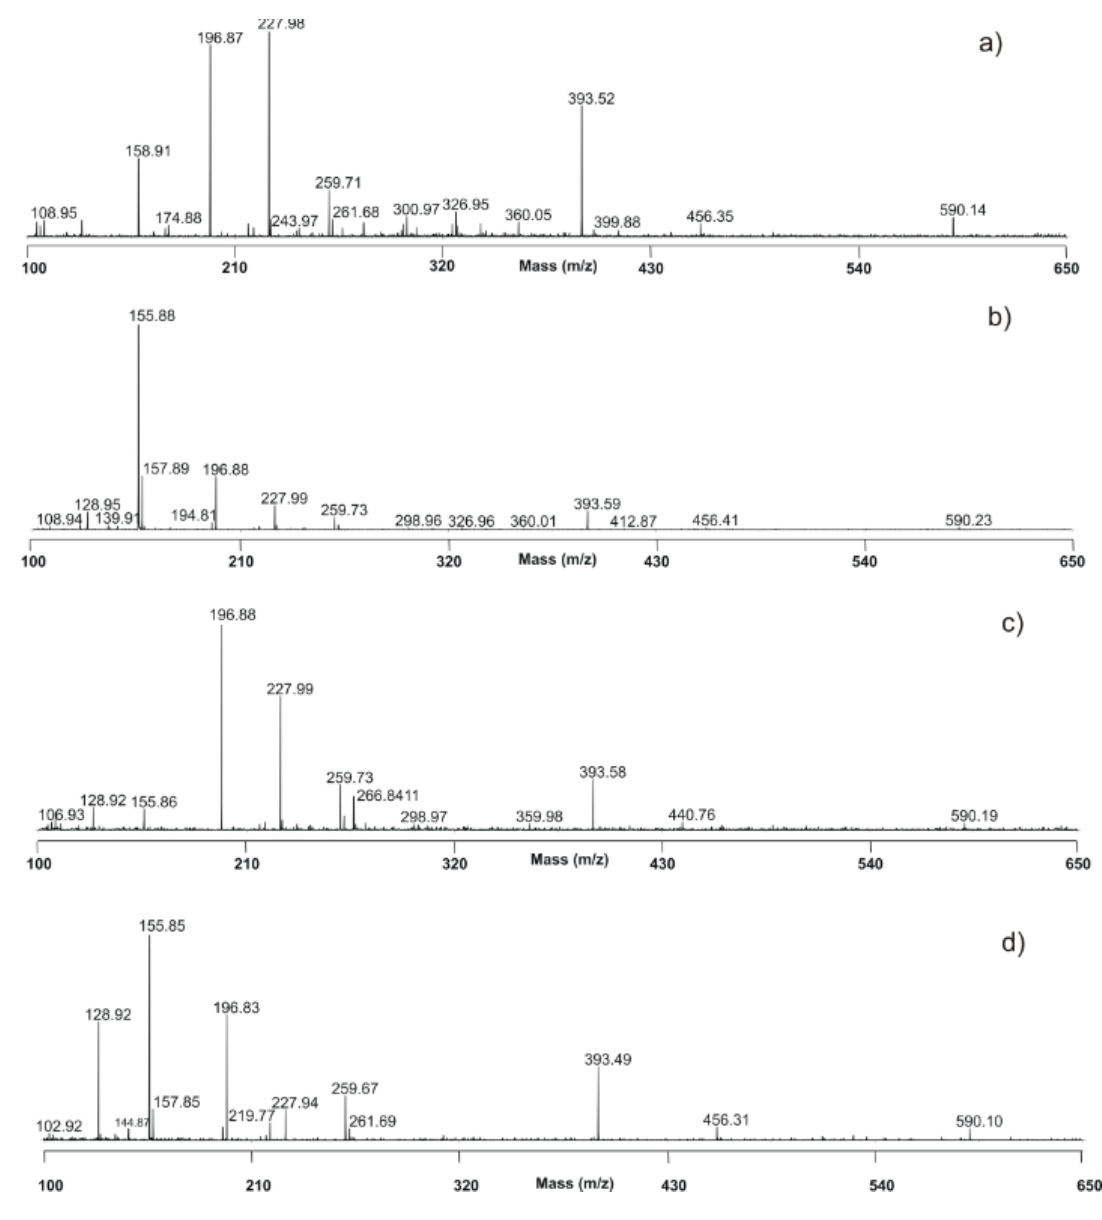
Figure 7. Matrix-assisted laser desorption and ionization time-of-flight (MALDI-TOF) analysis of ( a ) GP, ( b ) GP_CeO 2 _com, ( c ) GP_CeO 2 _SPRT and ( d ) GP_CeO 2 _MGNP.